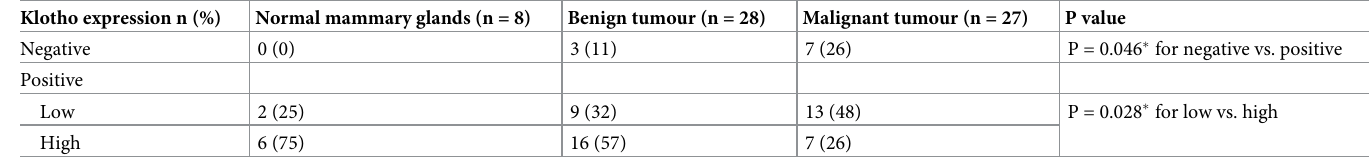
Table 2. Klotho expression in normal mammary glands, benign mammary gland tumours, and malignant mammary gland tumours. Klotho expression n (%)